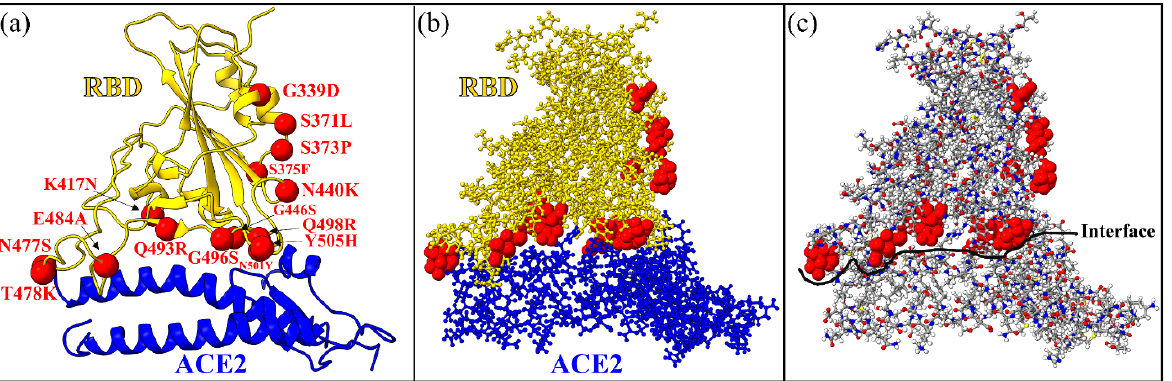
Figure 13. The RBD ‐ ACE2 interface model. ( a ) Ribbon structure showing the interface between RBD and the segment of ACE2. Mutated AAs of the RBD in OV are marked by red sphere. ( b ) The ball and stick structure of the same model as in ( a ). ( c ) Alternative version of ( b ) with more details of the atoms. Grey: C, red: O, blue: N, and white: H. In the WT interface model, there are 2993 atoms in RBD and 1824 atoms in ACE2 segment with a total of 4817 atoms. In the OV interface model, there are 3049 atoms in RBD and 1824 atoms in ACE2 segment for a total of 4873 atoms.